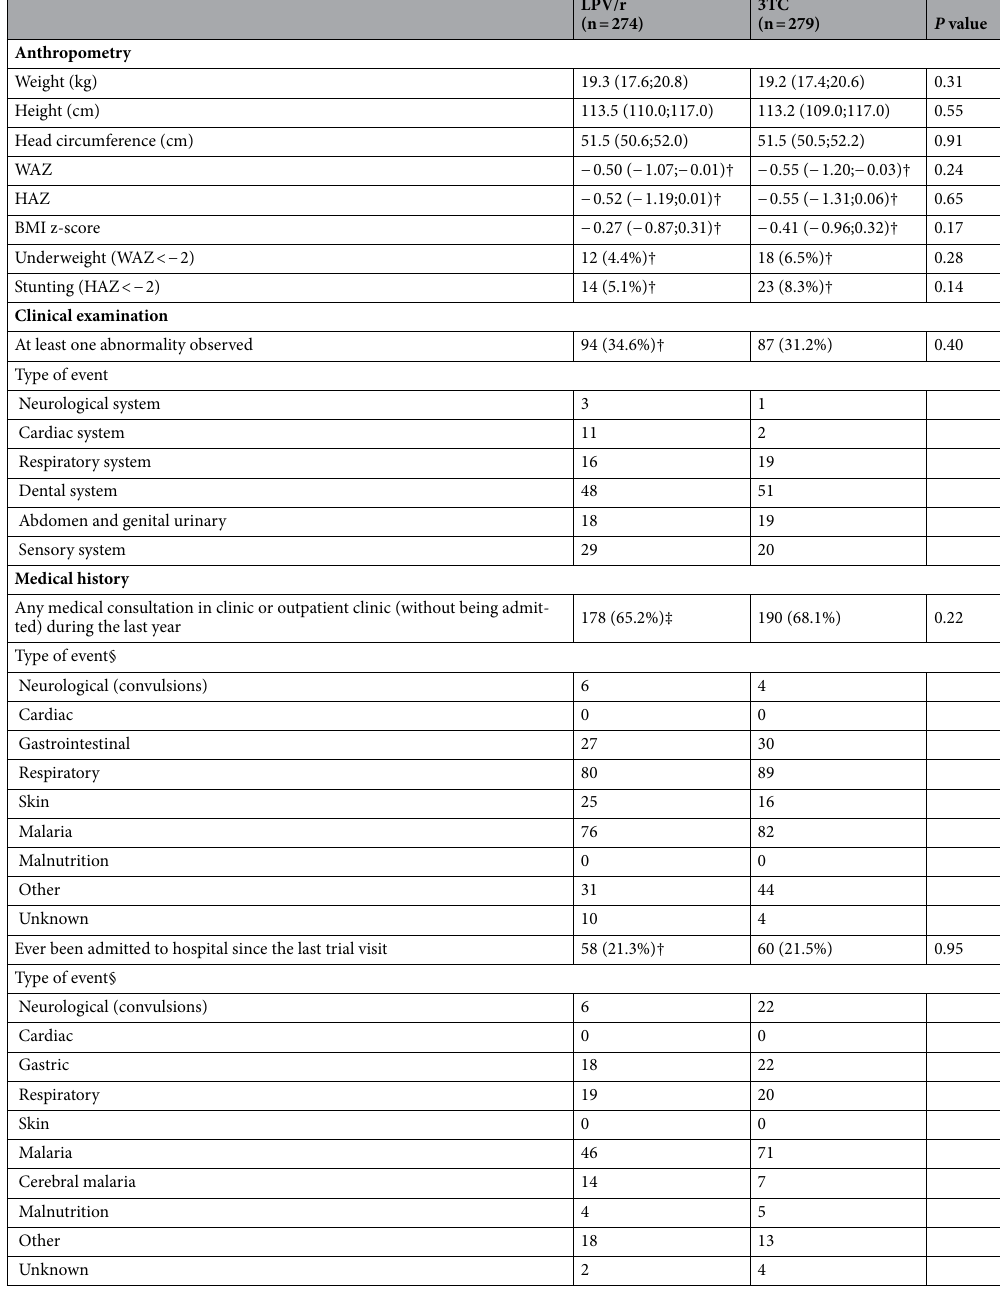
Table 2. Clinical outcomes of participants at M&S follow-up study by treatment group (N = 553). † 1